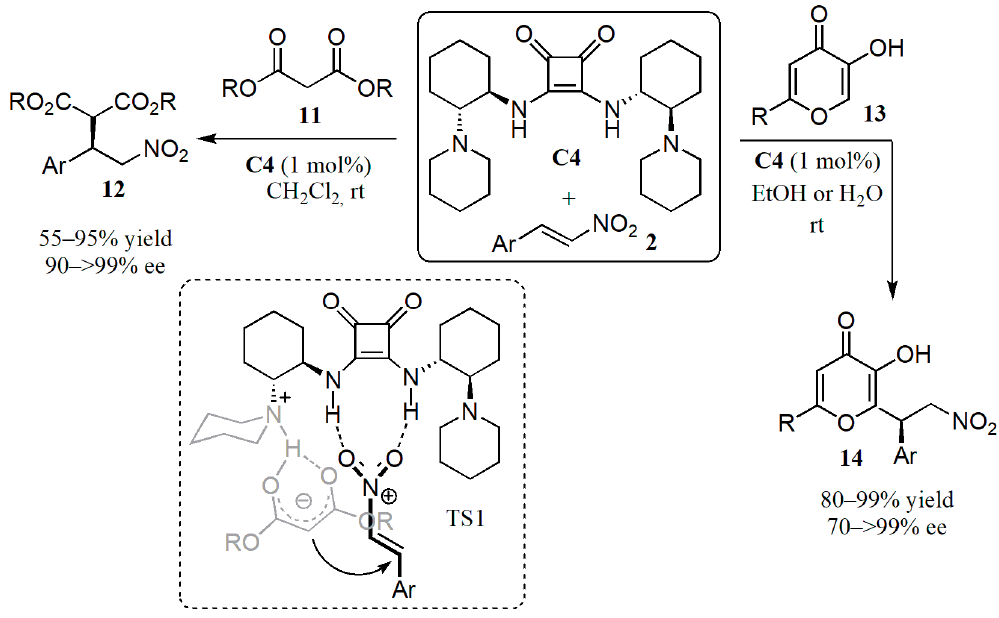
Figure 10. Asymmetric Michael reactions catalyzed by C 2 -symmetric amine-squaramide catalyst C4 and plausible transition state TS1 for the addition of the diesters to the nitroolefins [33].